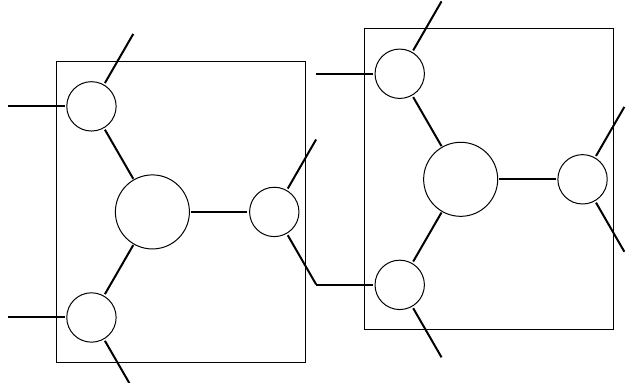
Figure 6: A contraction between two tensor trees along one index pair is shown. For clarity each tree has been placed in a